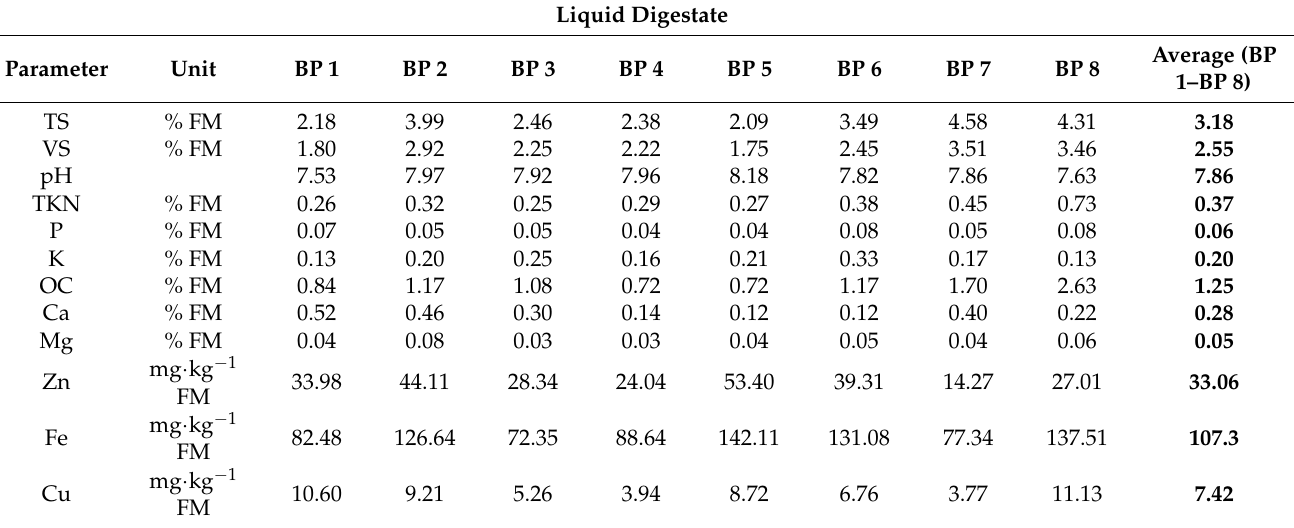
Table 4. Selected liquid digestate parameters for 8 biogas plants. Liquid